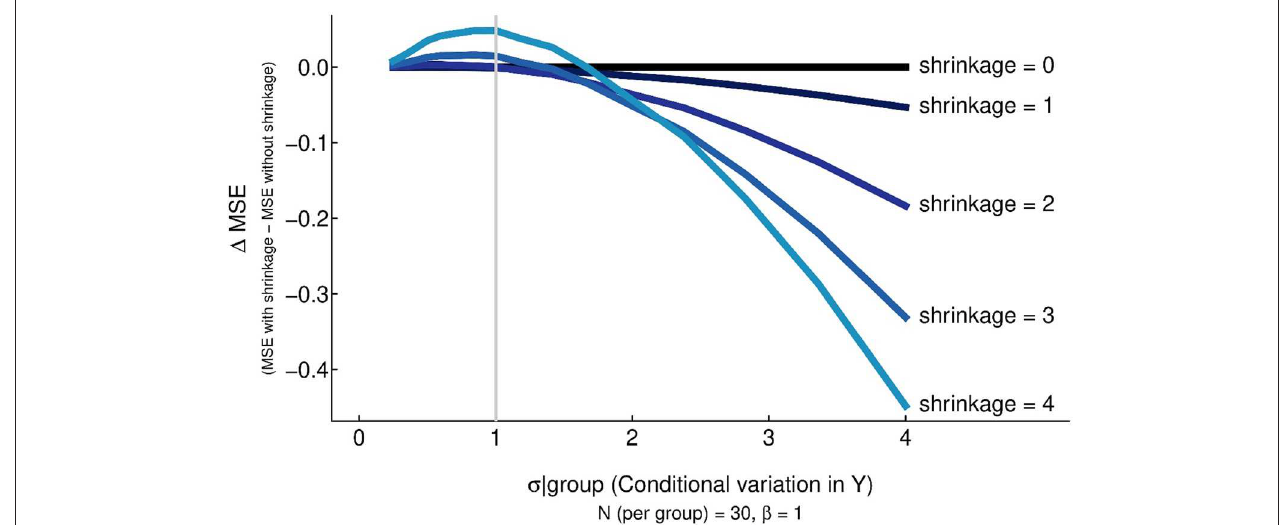
FIGURE 3 | An illustration of the relationship between the conditional variance, the degree of regularization/shrinkage, and the change in MSE when estimating the difference in means. The gray vertical line represents the effect size of the difference in means (1 SD). Shrinkage improves MSE when the conditional variance is large relative to the effect size, but it may increase MSE when the conditional variance is relatively comparable or smaller to the effect size.